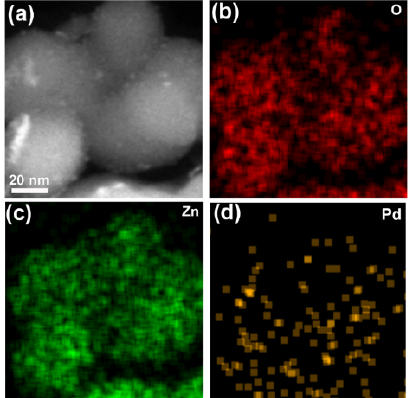
Figure 5. The EDX elemental mapping data of Pd Cs-2/ZnO 1−x : ( a ) TEM image, ( b ) O element, ( c ) Zn element, and ( d ) Pd element. ( c ) Zn element, and ( d ) Pd